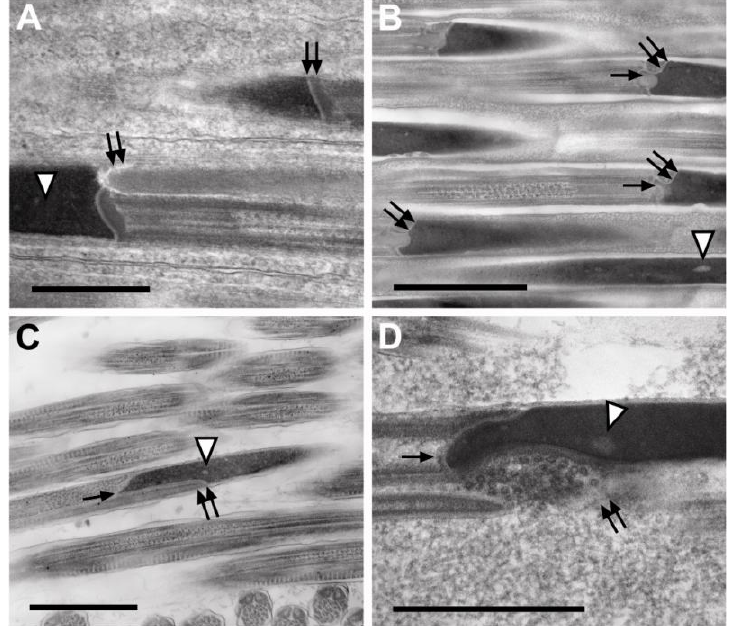
Figure 4. Junction of posterior end of nucleus with axoneme and mitochondrial derivatives. Each single arrow points to posterior process of nucleus that interfaces with the axoneme. Double arrows indicate the interface of sperm nucleus and mitochondrial derivative. Arrowheads point to uncondensed chromatin. ( A ) Hycleus scutellatus . ( B ) Zonitis flava. ( C ) Macrosiagon triscuspidata . ( D ) Eoxenos laboulbenei. Scale bars = 1.0 (cid:541) m in A (cid:177) C ; scale bar = 0.5 (cid:541) m in D